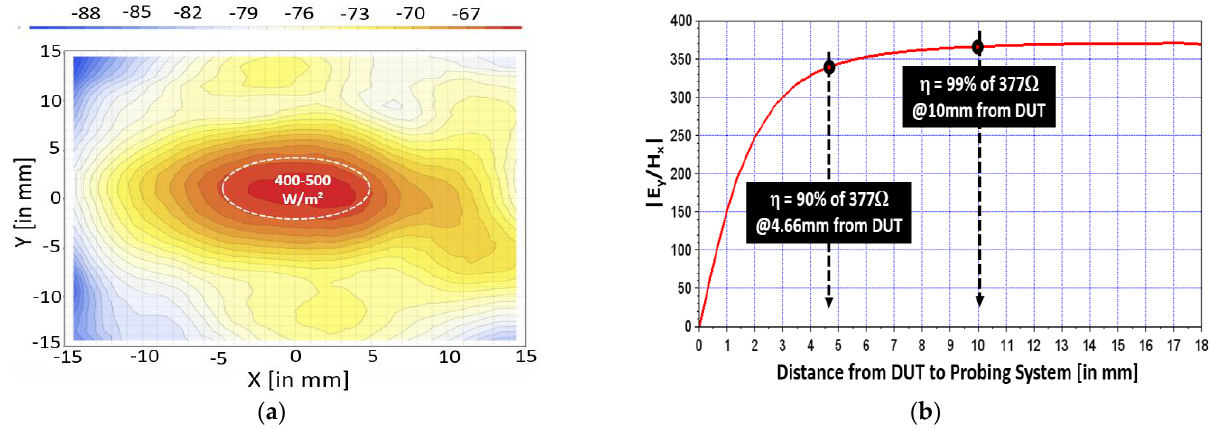
Figure 6. Measured power density at 26 GHz using electro-optical (EO) probing ( a ) and field-based extraction of wave-impedance ( b ) as function of distance between the DUT and the electro-optical probing.